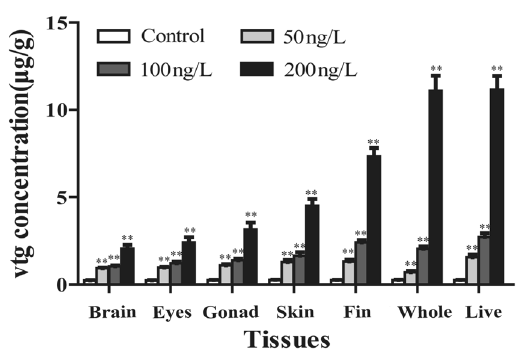
Figure 9. Concentrations of Vtg in guppy exposed to 50, 100, and 200 ng/L E 2 for 21 days. Values are means ± S.D and asterisks indicate statistically significant difference from the control group ( ** P <